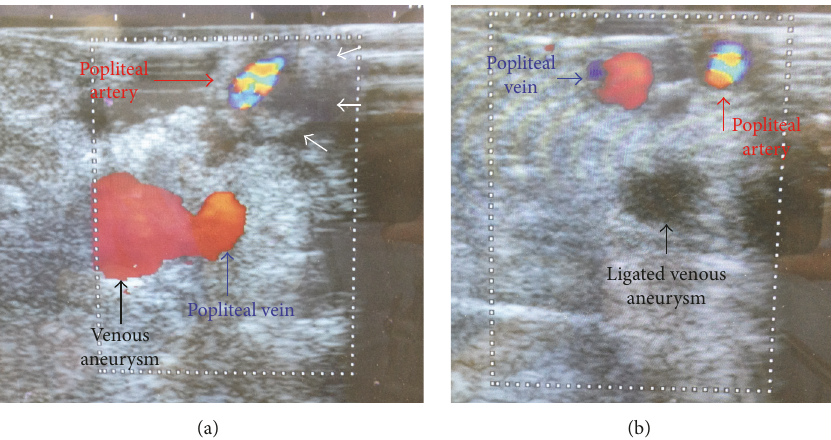
Figure 4: (a) Intraoperative echo findings revealed cystic adventitial lesion compressed internal lumen of popliteal artery (white arrow). (b) Intraoperative echo findings after resection of adventitial cyst revealed improved arterial compression and ligated venous aneurysm without blood flow (black arrow).